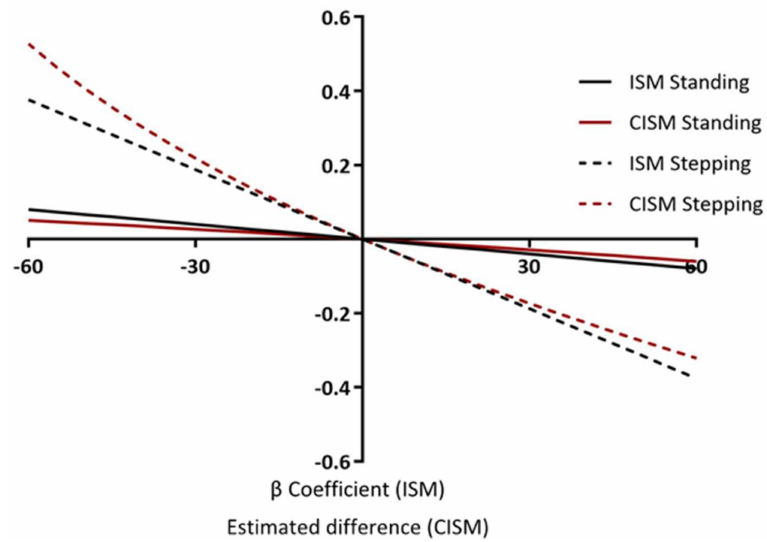
Figure 4. Incremental reallocations: multiple behavioural reallocations examining 5-min increments on